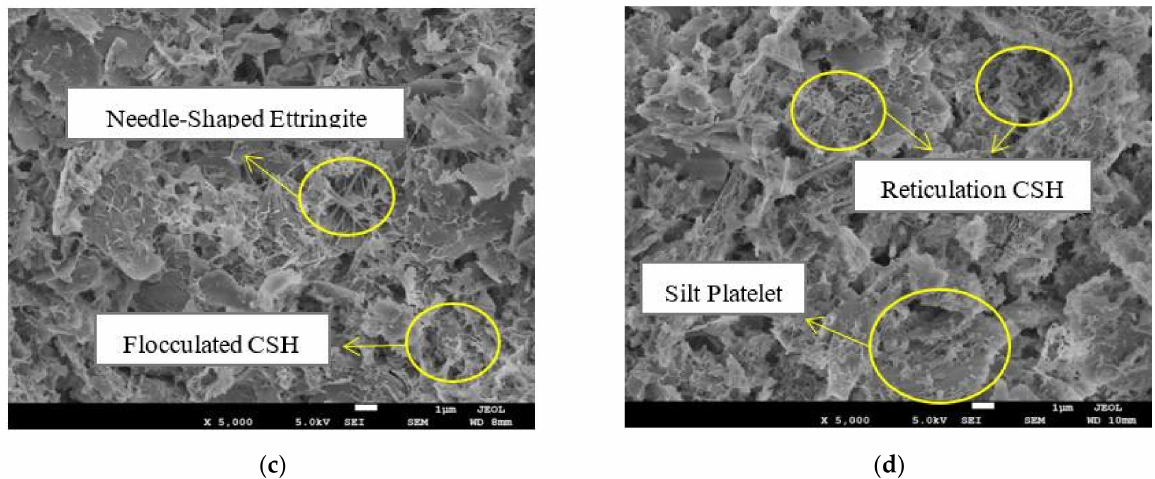
Figure 14. SEM images of specimen treated by 30% cement with different silt contents: ( a ) S1 + 30% cement, ( b ) S2 + 30% cement, ( c ) S3 + 30% cement, ( d ) S4 + 30%